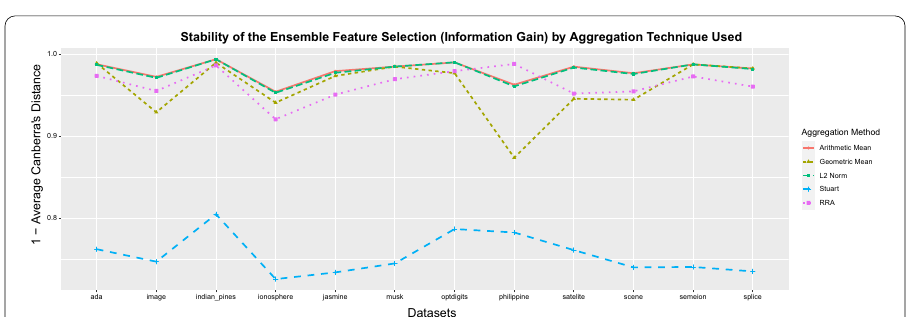
Fig. 15 Stability Analysis using Canberra’s Distance (IG)